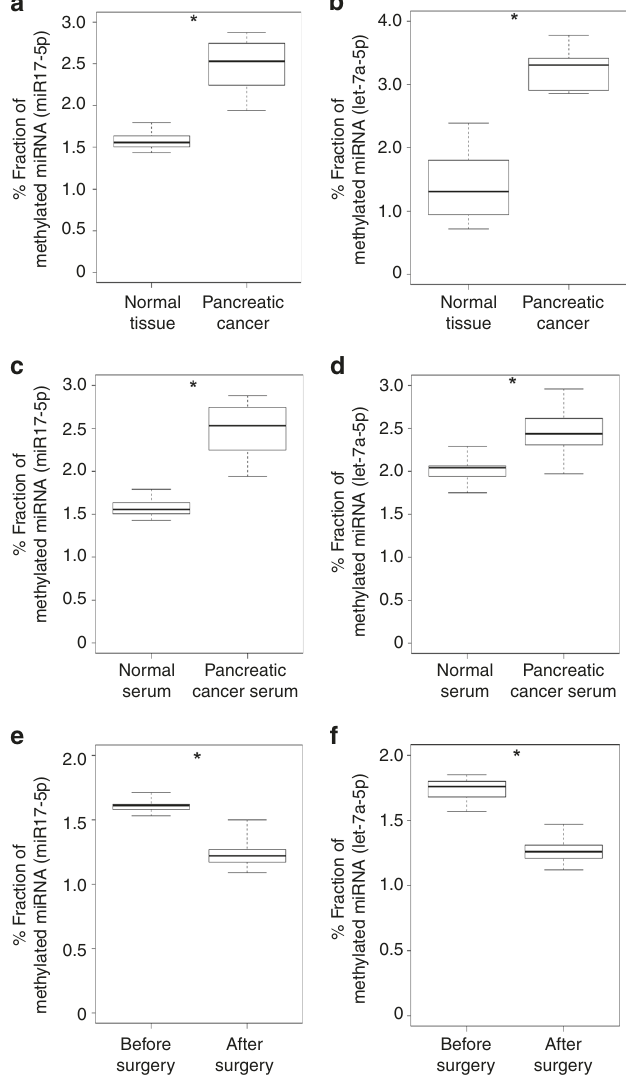
Fig. 3 Increased miRNA methylation levels in pancreatic cancer tissue and serum. a , b Enhancement of miR-17-5p ( a ) and let-7a-5p ( b ) methylation in pancreatic cancer tissue ( n = 12) relative to paired healthy tissue ( n =